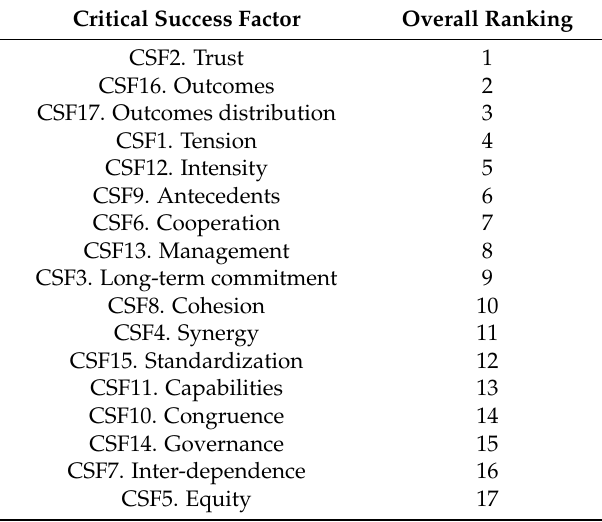
Table 6. Ranking of Critical Success